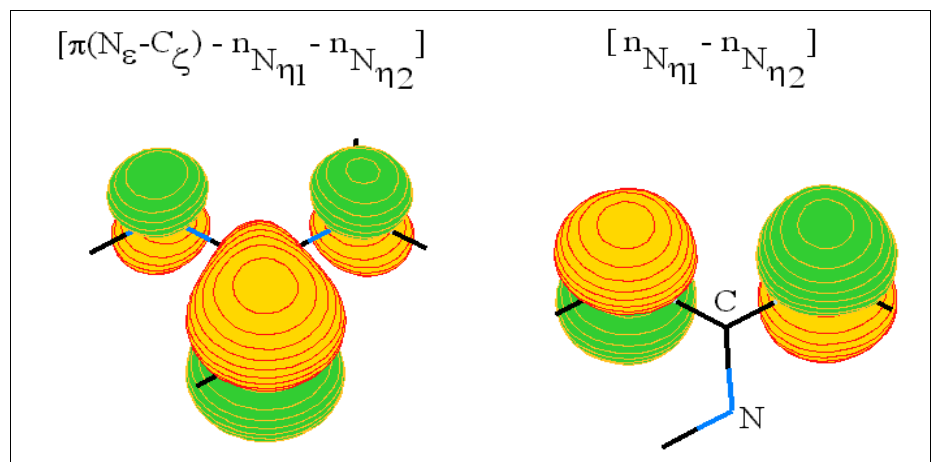
Figure 5: π -Type MO on Arg side